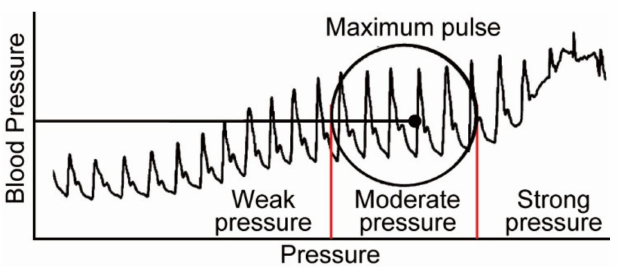
Figure 1. Changes in the amplitude of the blood pressure pulse wave when the wearing state is changed [9].